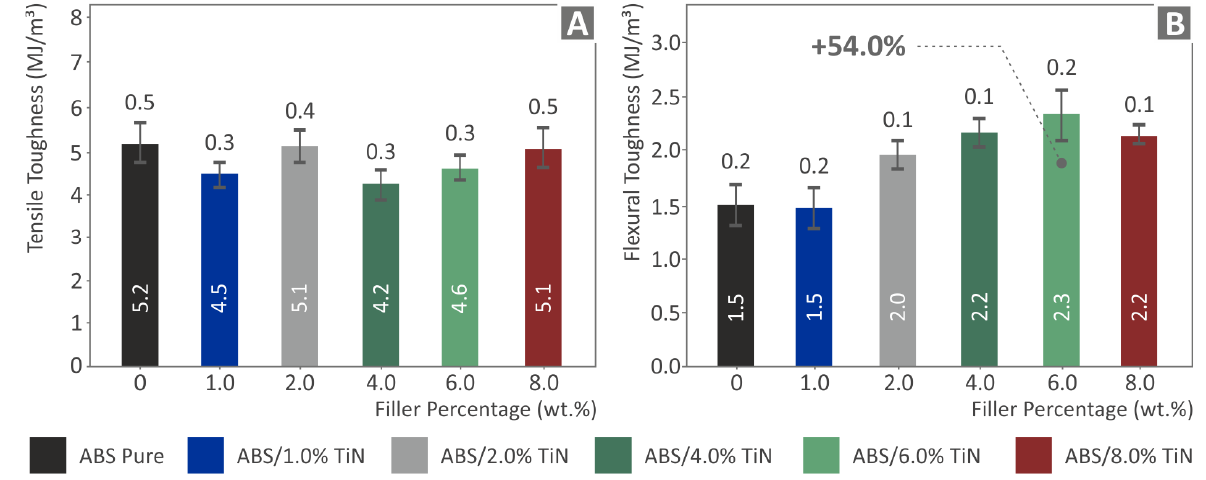
Figure 11. Average values and deviation of the ( A ) Tensile toughness and ( B ) flexural toughness results for the six 3D-printed specimens. Table 2. Summary of the mechanical test results.